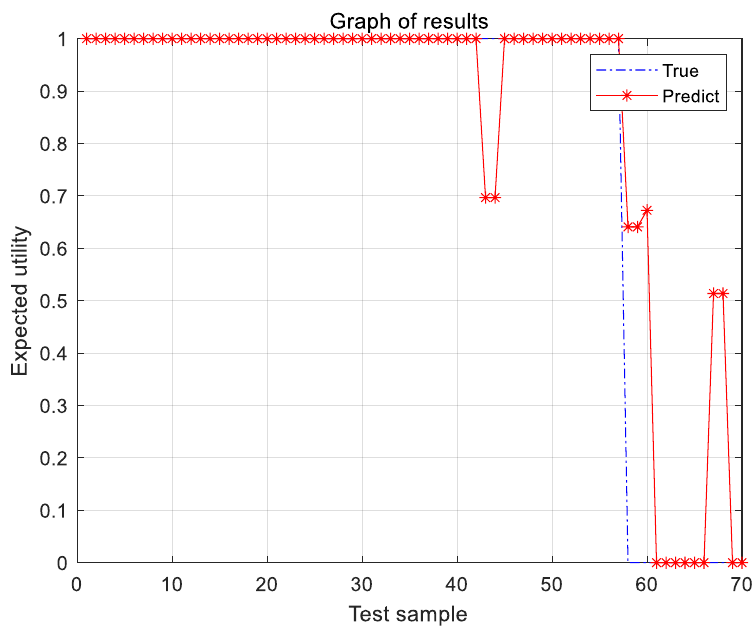
Figure 6. Plot of traditional BRB model fits after process.